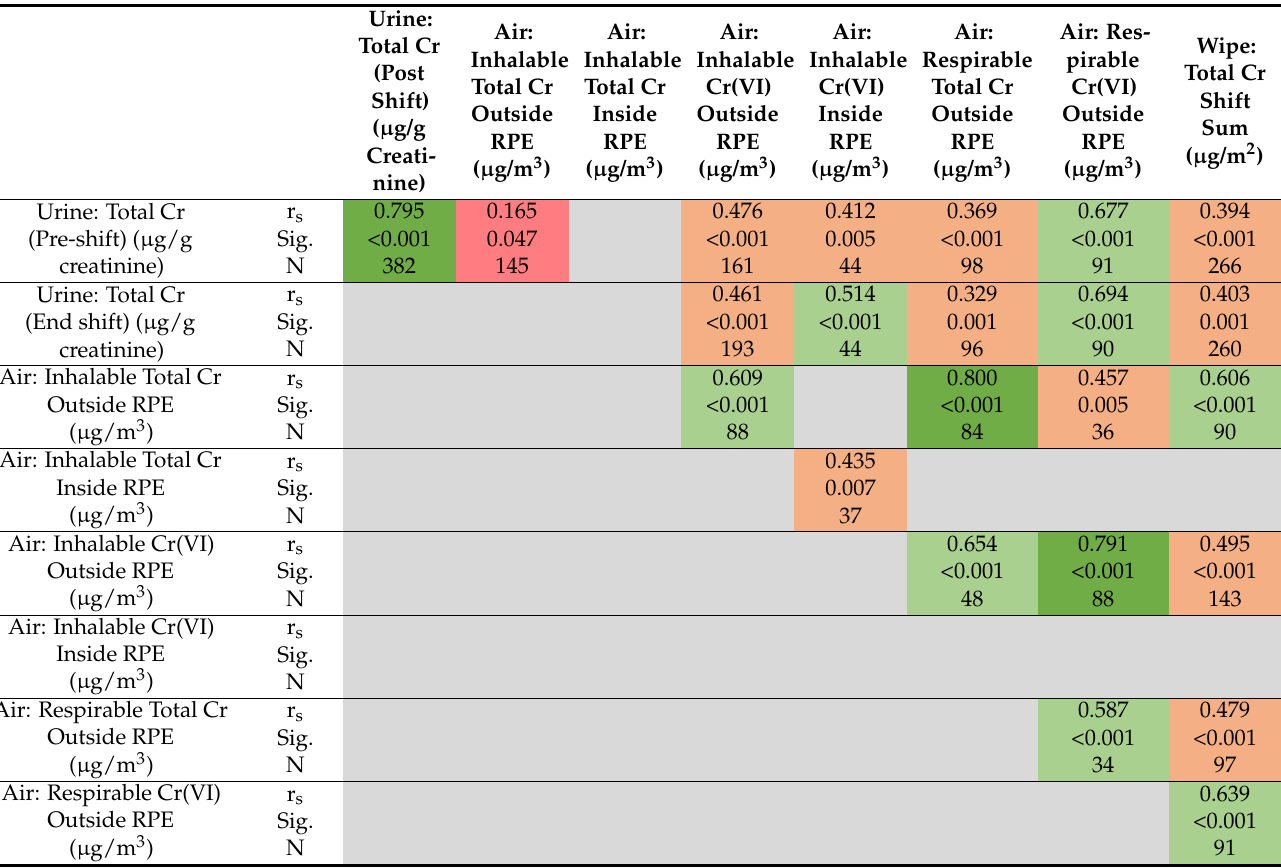
Table 4. Heatmap representing Spearman coefficient correlation (r s ) analysis for total Cr and Cr(VI) levels in biological samples (urine) and industrial hygiene samples (air and wipe). Only significant correlations are displayed (Sig. = p < 0.05). Red cell: ≤ 0.2 = poor; Orange cell: 0.2 ≤ 0.5 = fair; Light correlation found.